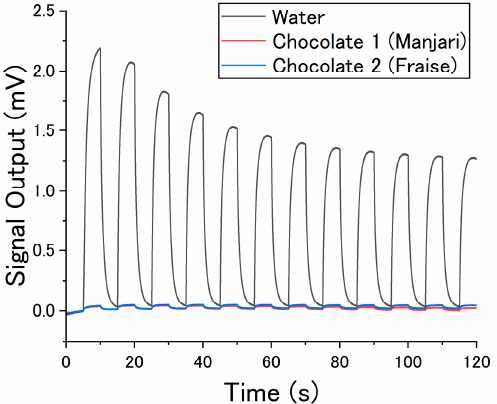
Figure 1. Sensing outputs of the measurements with the PPPO-coated MSS. Vapors of ultrapure water and two chocolates (“Manjari” and “Fraise” flavors) were used as samples. The sample vapors and the carrier gas (deodorized and dehumidified air) were alternately injected into the MSS with an interval of 5 s. The baselines are corrected so that the signal output at 5 s is 0 mV. The measurement protocol follows the normal measurement, which is explained in Section 2.